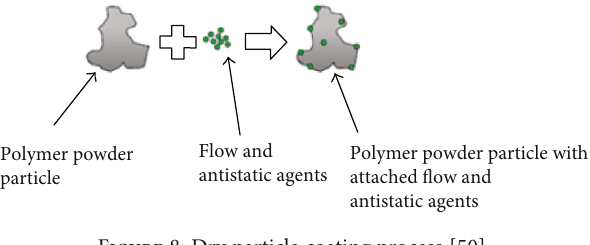
Figure 8: Dry particle coating process